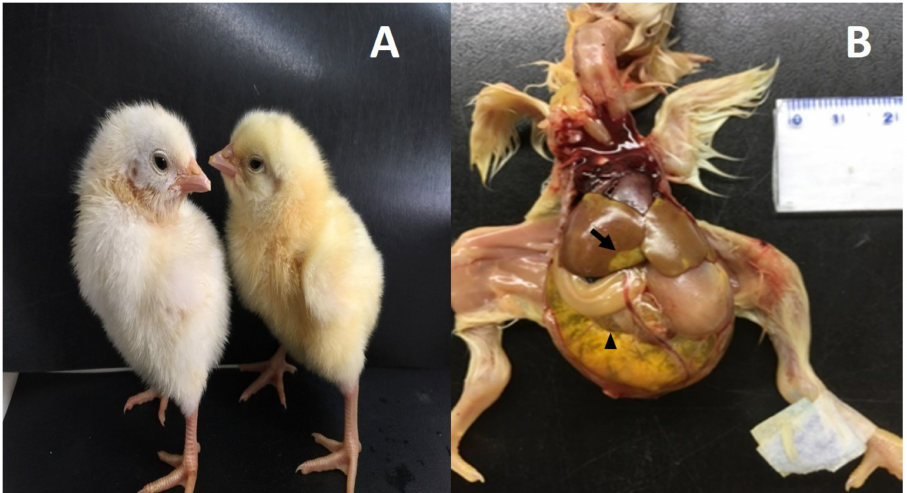
Figure 1. Macroscopic lesions observed in animals a ff ected with white chick syndrome (WCS); ( A ): left: chick a ff ected with WCS, right: non-a ff ected chick; ( B ): macroscopic lesions present in jejunum and liver in the animals with WCS; hepatomegaly, with focal pale yellow areas (arrow), and duodenal loop filled with liquid